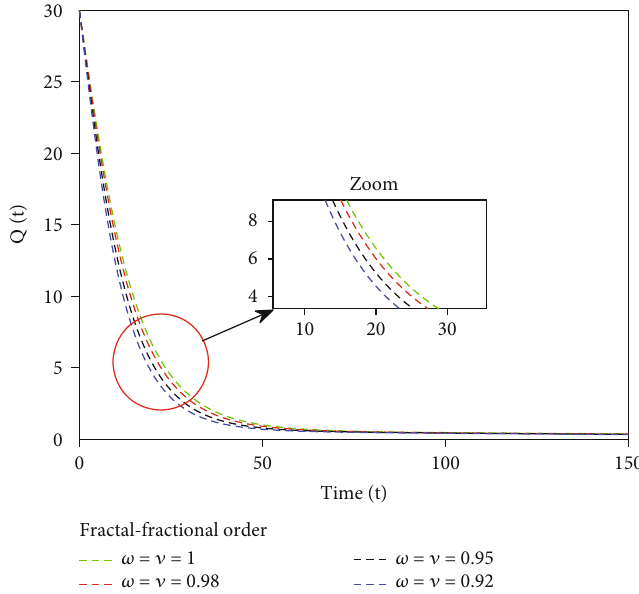
𝜔 = 𝜈 = 1 𝜔 = 𝜈 = 0.98 Figure 12: The simulation of the function Q ð t Þ during the time t for fractal dimensions and fractional orders ω = ν = 1,0 : 98,0 : 95,0 : 92